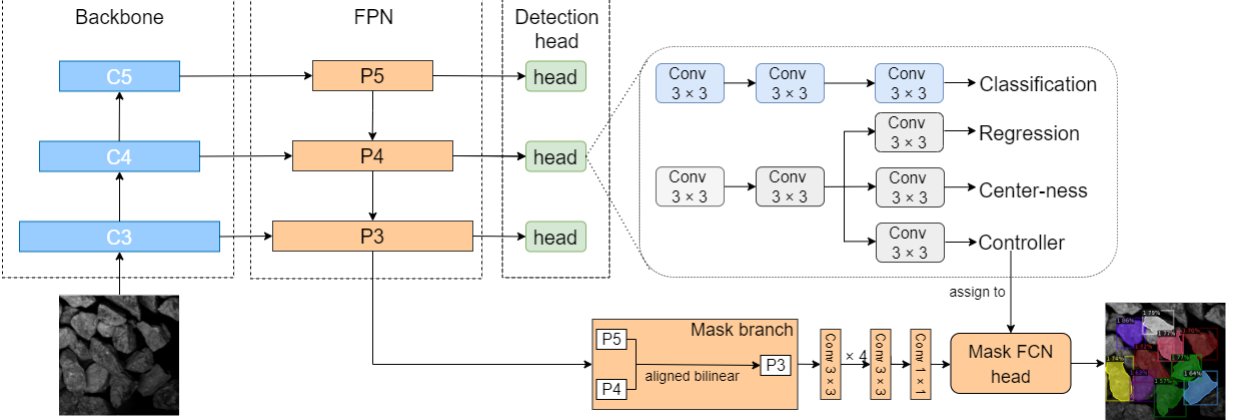
Figure 2. Architecture of the proposed LosNet. In the feature pyramid networks (FPN), 1 × 1 convolutions are retained for feature channel dimension alignment extracted from the backbone. The detection head consists of four branches. The centerness branch is used to suppress the low- quality detected bounding boxes. The controller branch is used to generate the parameters of the mask full convolution network (FCN) head. In the mask branch, the feature maps P4 and P5 are added to P3 after the linear calculation. Then, these feature maps are input into the mask FCN head to obtain the final